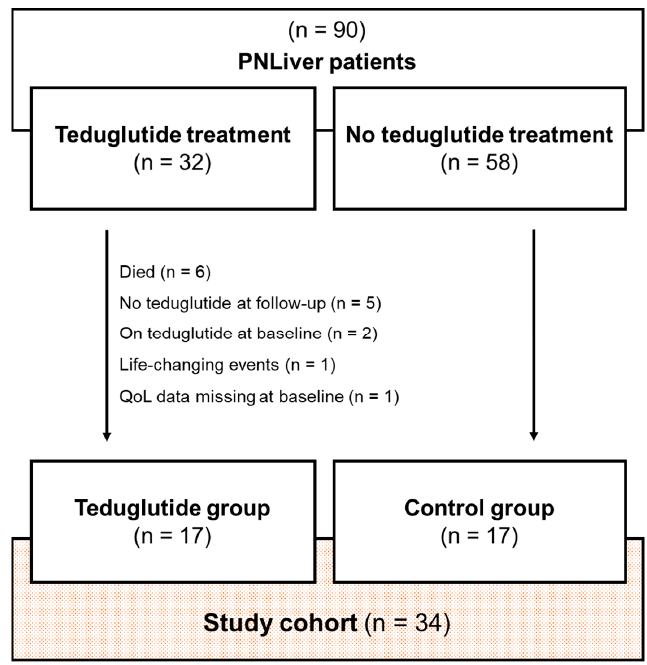
Figure 1. Study fl ow chart. Figure 1. Study flow